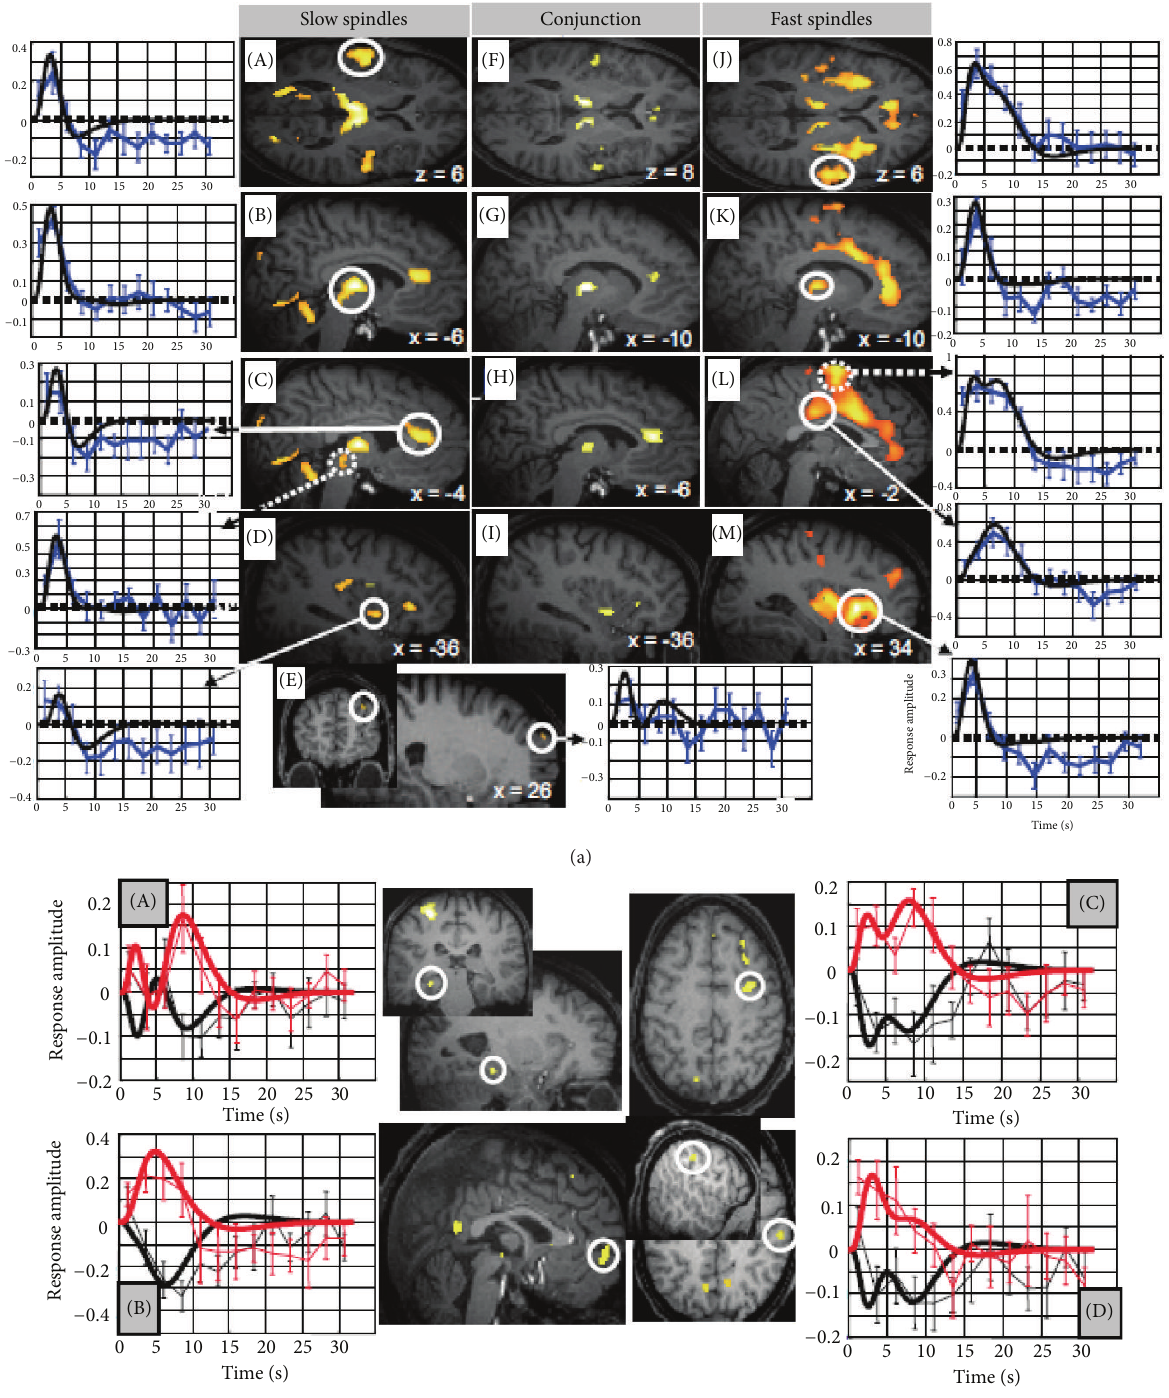
(b) Figure8:(a)Maineffectsoflateslowandearlyfastspindles.(A–Eleft)fMRIresponsestoslowspindlesdisplayedoveranindividualstructural image normalized to the Montreal Neurological Institute space ( 𝑃 < 1 ). The leftmost panels show peristimulus time histograms (PSTHs) depicting the responses in auditory cortices (circled) (A), thalamus (B), anterior cingulate (circled) and midbrain tegmentum (dotted) (C), anterior insula (D), and superior frontal gyrus (E). The PSTH (solid blue line; blue error bars reflect the SEM) depicts the mean response across spindles of the corresponding voxel, irrespective of contrast based on a finite impulse response refit. The fitted response is drawn in black. (F–I center) Conjunction analysis of slow and fast sleep spindles. (J–M right) fMRI responses to fast spindles ( 𝑃 uncorrected < 0.001 ). The right most panels show PSTHs depicting the response in superior temporal gyri (J), thalami (K), midcingulate cortex (circled) and SMA (dotted) (L), and anterior insula (M). (b) Differential fMRI activity between fast and slow spindles. Larger brain responses for fast (red) than slow (black) spindles were revealed in the hippocampus (A), mesial prefrontal cortex (B), precentral gyrus (C), and postcentral gyrus (D). Peristimulus time histograms show mean response of the corresponding voxels (dotted lines; error bars show SEM) and the corresponding fitted responses (continuous lines). Modified from